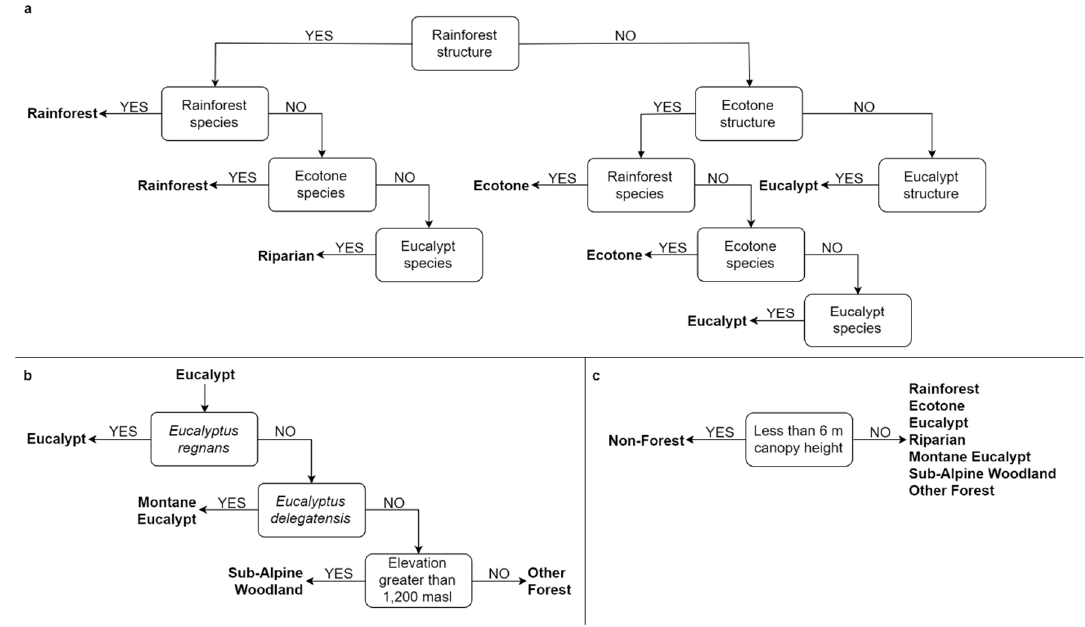
Figure 3. Decision tree for ( a ) predictive ecosystem mapping (PEM) model stand type classification map based on the combination of the landscape structure model and the landscape species model, ( b ) eucalypt forest classification into montane eucalypt, sub-alpine woodland and other forest, and ( c ) the distinction between forest and non-forest areas.